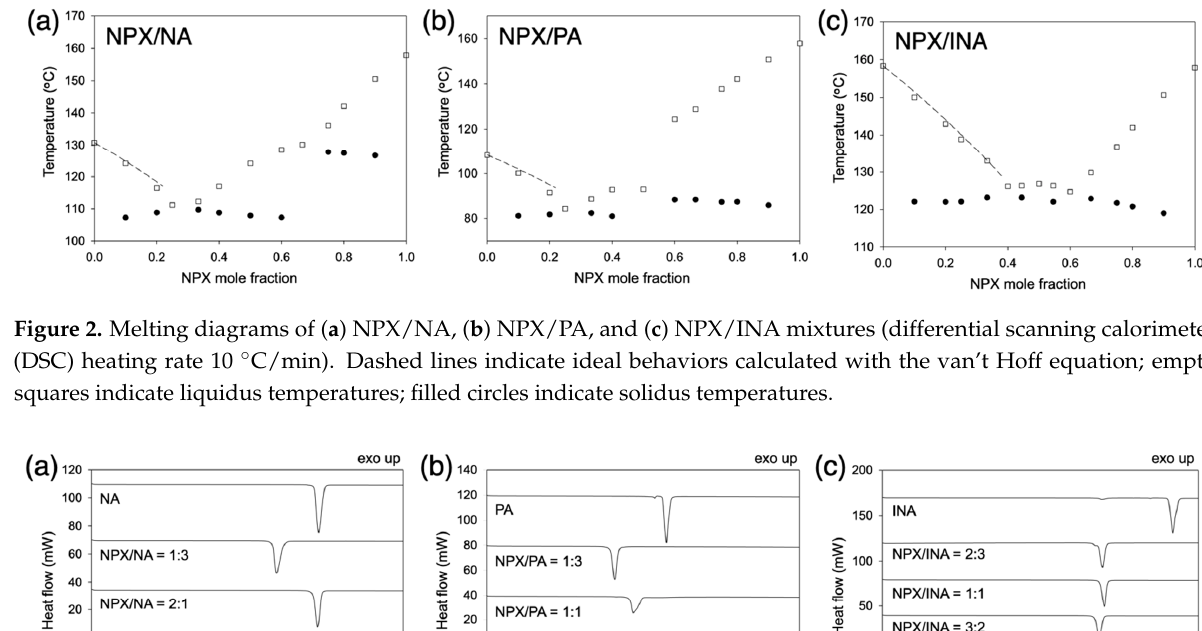
Figure 2. Melting diagrams of ( a ) NPX/NA, ( b ) NPX/PA, and ( c ) NPX/INA mixtures (differential scanning calorimeter (DSC) heating rate 10 °C/min). Dashed lines indicate ideal behaviors calculated with the van’t Hoff equation; empty squares indicate liquidus temperatures; filled circles indicate solidus temperatures.